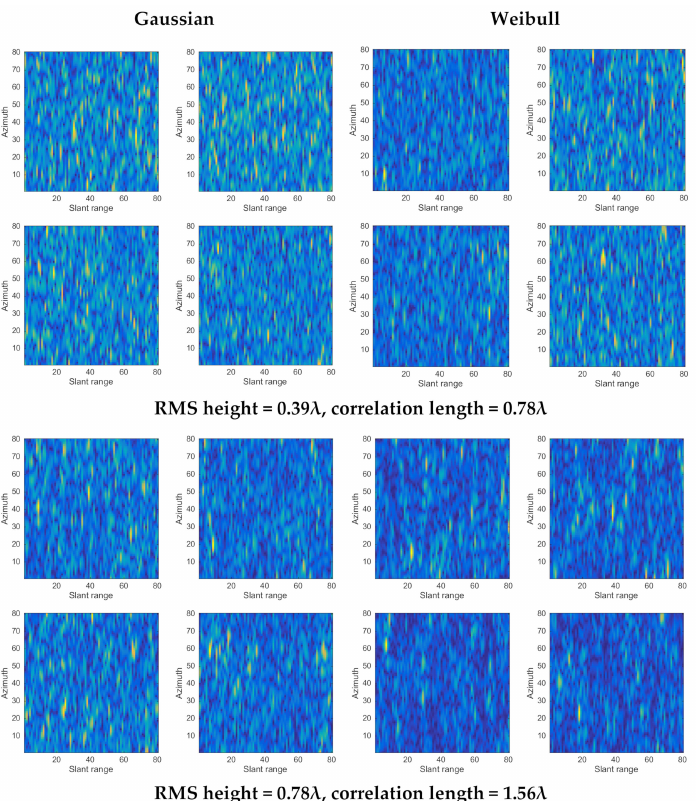
Figure 5. Sample SLC images of Gaussian HPD surface ( left panel) and Weibull HPD surface ( right panel). Two roughness (RMS height and correlation length) are